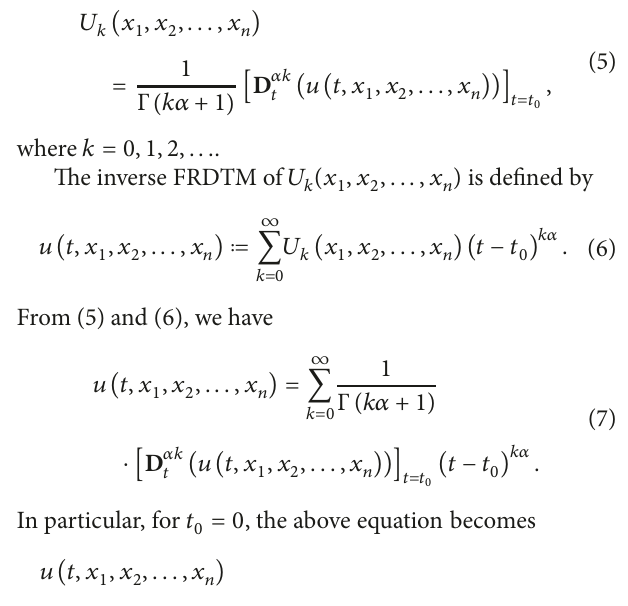
Table 1: Fundamental operations of FRDTM [23, 24, 29, 30]. Original function Transformed